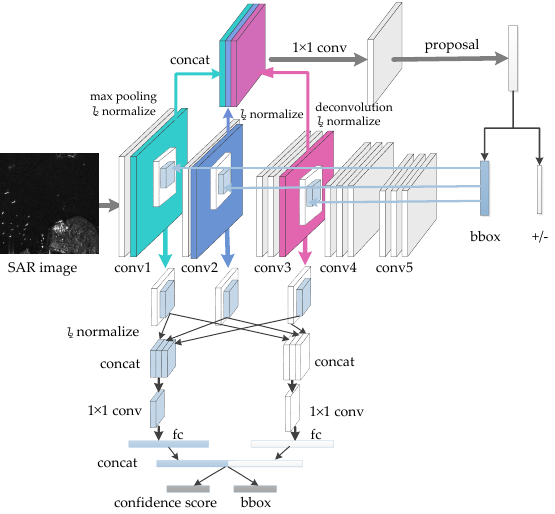
Figure 1. The architecture of the proposed network. SAR images are fed into VGG16 which has five sets of layers for feature extraction. The upper part is the RPN of the network. The white blocks and light blue blocks represent contextual features and ROI features respectively, which are processed concurrently in the object detection